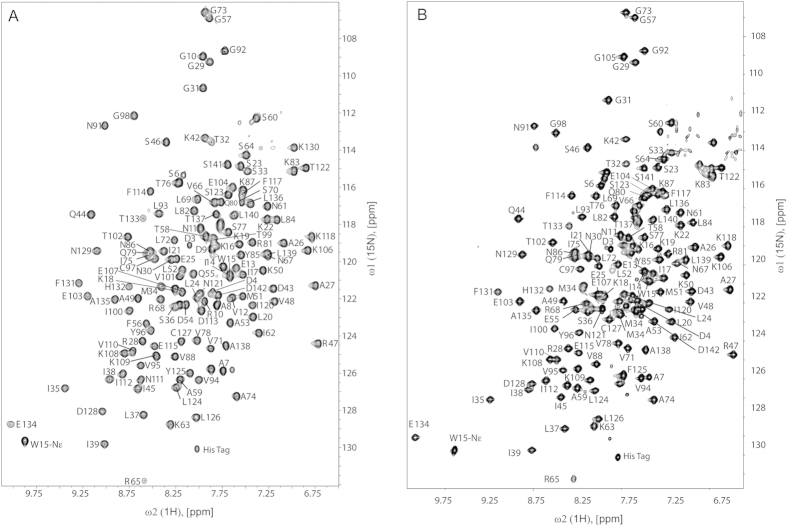
2D [15N,1H]-TROSY at 700 MHz proton frequency of mutant eRF1 (A) E55Q and (B) Y125F in 20 mM MES-K (pH 6.0), 100 mM KCl, 90% H2O/10% D2O at 298 K. Residue specific assignments of the amide resonances are labeled.